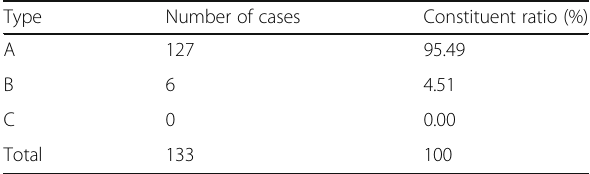
Table 4 Comprehensive evaluation of occurrence types of ADR/ ADE